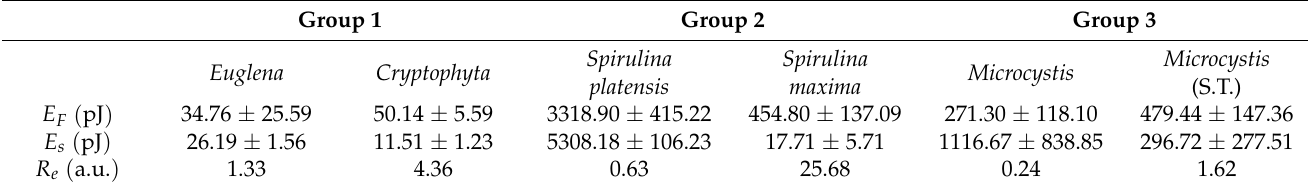
Table 1. Quantitative analysis of acoustic and optical